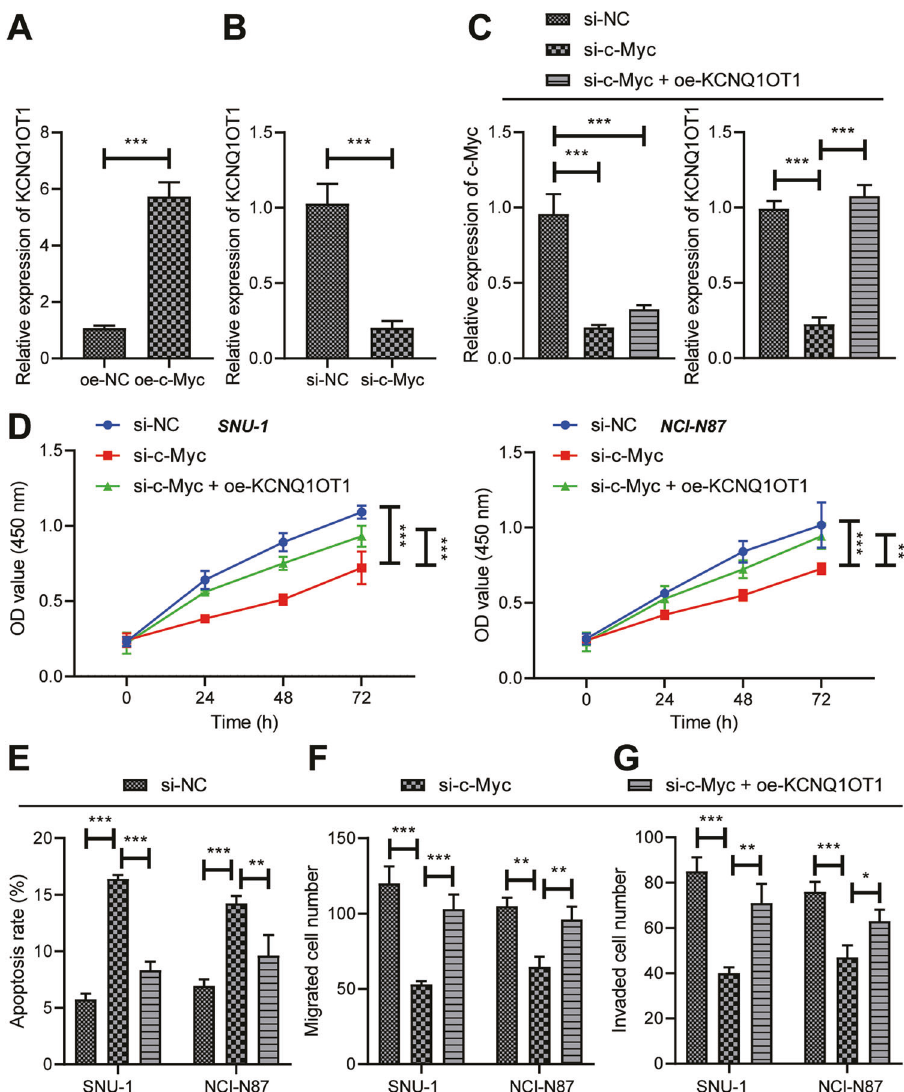
Fig. 4 c-Myc silencing inactivates KCNQ1OT1 to dampen GC cell viability, migration, and invasion. A The expression of KCNQ1OT1 in GC cells overexpressing c-Myc determined by RT-qPCR. B RT-qPCR was used to detect the expression of KCNQ1OT1 in GC cells knocking down c-Myc. GC cells were transfected with si-NC, si-c-Myc, or si-c-Myc + oe-KCNQ1OT1. C RT-qPCR was used to detect the expression of c-Myc and KCNQ1OT1 in cells. D Cell viability determined by CCK-8. E Cell apoptosis rate measured by fl ow cytometry. F Cell migration detected by Transwell assay. G The invasion of GC cells assessed by Transwell assay. * represents the comparison between the two groups. * p < 0.05; ** p < 0.01; *** p < 0.001. The cell experiment was repeated 3